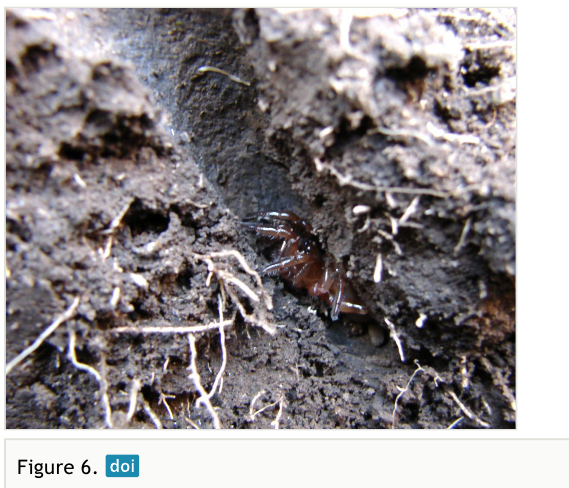
Burrow shape of a juvenile of C.